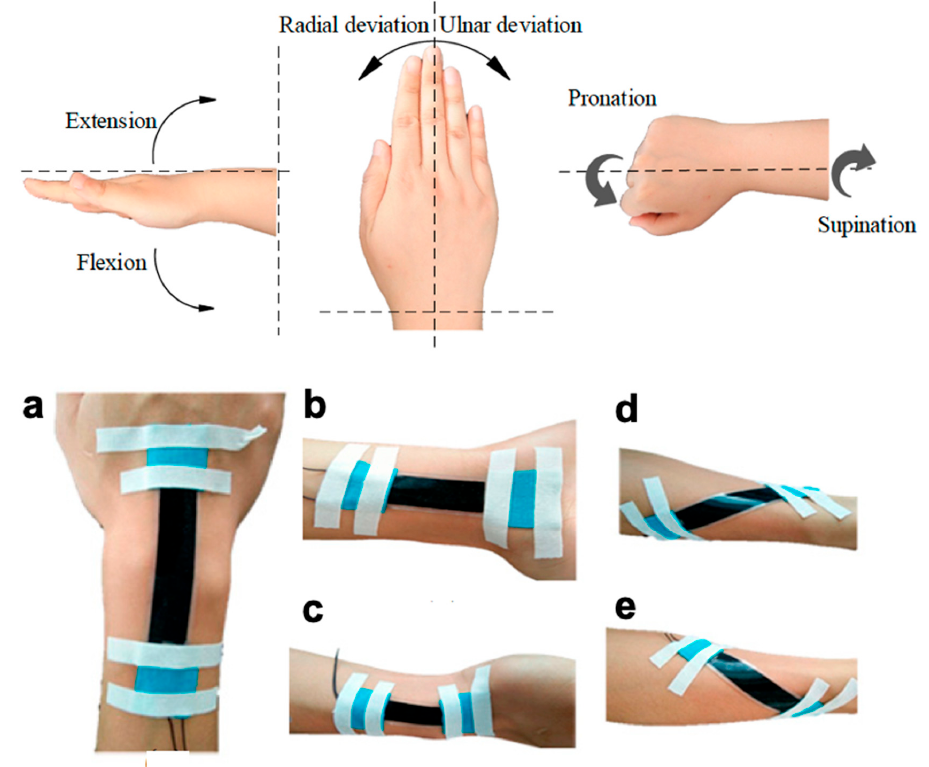
Figure 10. Decomposition of possible wrist motions for the wrist joint along with corresponding placement of a capacitive motion sensor for tracking of ( a ) flexion ( b ) extension ( c ) Ulnar deviation ( d ) pronation ( e ) supination [222]. Reproduced with permission as licensed under the Creative Commons Attribution 4.0 International License. Table 2. Summary of performances of representative wearable strain sensors for motion detection reported.